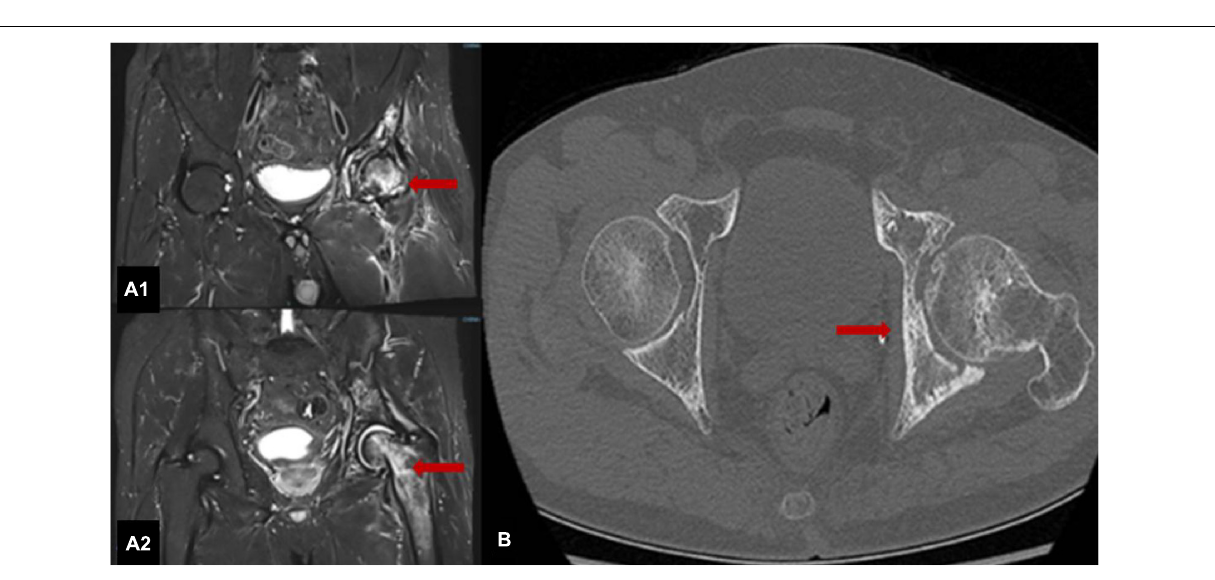
FIGURE 2 | MRI scans of both hips show that the shapes of the left femoral head and upper femur are normal, with patchy T1 and T2 signals, uneven signals and patchy low-signal areas; the right hip joint adjacent bone shows uniform signals (A1,A2) . The left hip joint is narrow, and the articular surface is not smooth; the left femoral head is slightly flattened with a patchy high-density shadow with an unclear boundary (B)